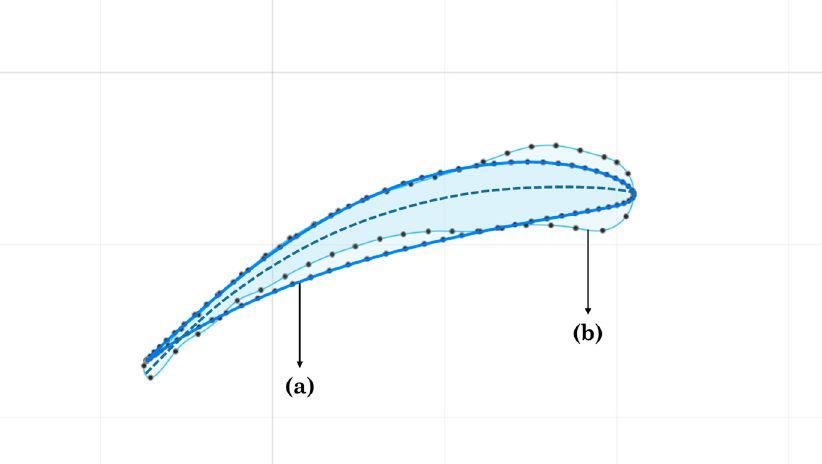
Figure 6. Fitting known database profiles procedure: (a) airfoil CH10, (b) scanned section of the bird wing at 3 cm from the base. Screenshot taken from Autodesk Fusion 360 © 2020 Autodesk, Inc.